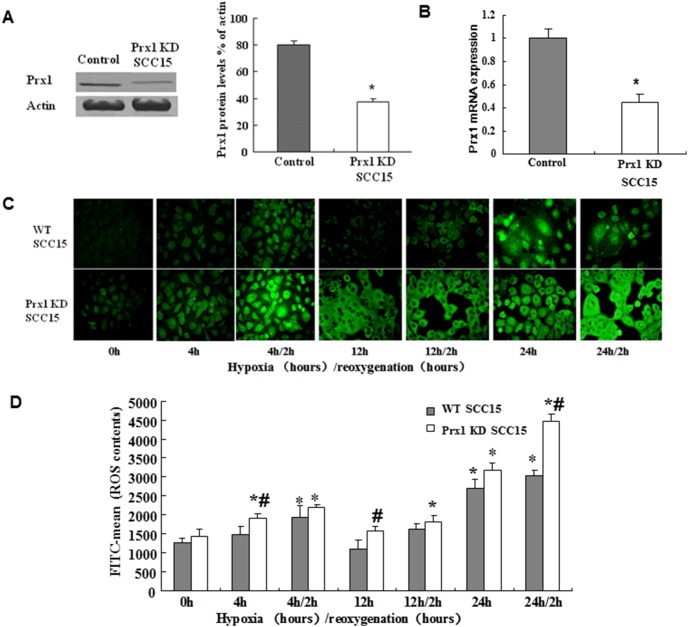
Prx1 knockdown increases hypoxia and intracellular ROS production in SCC15 cells.A, Prx1 protein was significantly decreased by shRNA transfection. B, Prx1 mRNA was significantly reduced by shRNA transfection. C, Pimonidazole staining showed the increased hypoxia status in cells after hypoxia/reoxygenation treatment. D, Intercellular ROS level identified by flow cytometry in cells after hypoxia/reoxygenation treatment. *P<0.05 vs. WT SCC15 cells; #
P<0.05 vs. control hypoxic WT SCC15 cells.